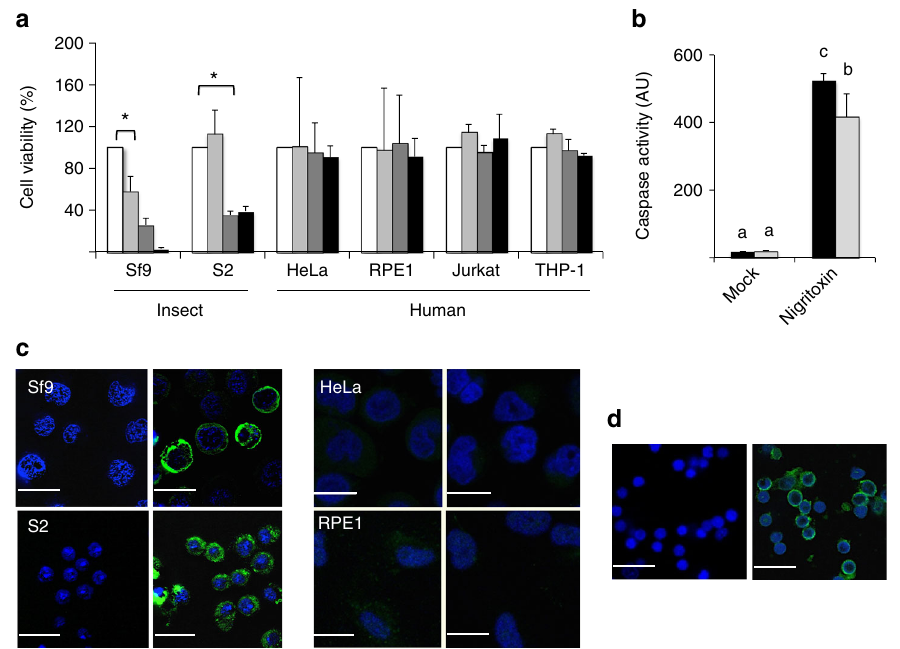
Fig. 2 Cytotoxic activity of the nigritoxin on different cell lines. a Two insect (Sf9 and S2) and four human (HeLa, hTERT RPE-1, Jurkat, and THP-1) cell lines were incubated with nigritoxin (1.2 μ M) for 0, 6, 12, and 24 h (white, light gray, dark gray, and black bars, respectively). The cytotoxicity expressed in percentage ( y -axis) was monitored using Alamar Blue assay. The experiment was performed twice in triplicate and data are presented as mean ± S.D. A star indicates signi fi cant difference between treatment (ANOVA, p < 0.05) b Sf9 and S2 cells (black and gray bars, respectively) were either mock-treated or incubated with 1.2 μ M nigritoxin for 12 h. Caspase activity was determined using Ac-DEVD-MCA as a substrate. The experiment was performed in triplicate and data are presented as mean ± S.D. Means with the same letter are not signi fi cantly different from each other (Kruskal – Wallis, p < 0.05). c Insect and human cell lines were incubated with nigritoxin (1.2 μ M) for 6 h, then washed, fi xed, and reacted with a speci fi c anti-nigritoxin polyclonal antibody and Alexa Fluor-488-conjugated secondary antibody (green). Nuclei were stained with DAPI. Left image, mock-treated cells; right image, nigritoxin-treated cells. d Primary hemocytes from shrimp Litopenaeus vannamei were treated and analyzed as described in c . Scale bars: 20 μ